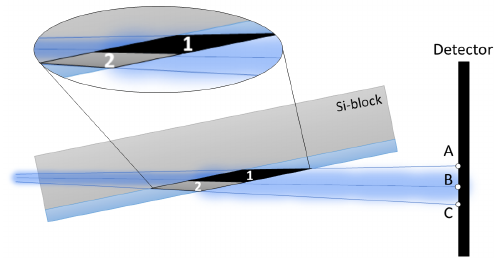
Figure 3. Schematic illustration of the transmission in grazing incidence geometry: difference in the footprints of the upper- and lower- beam parts due to the beam